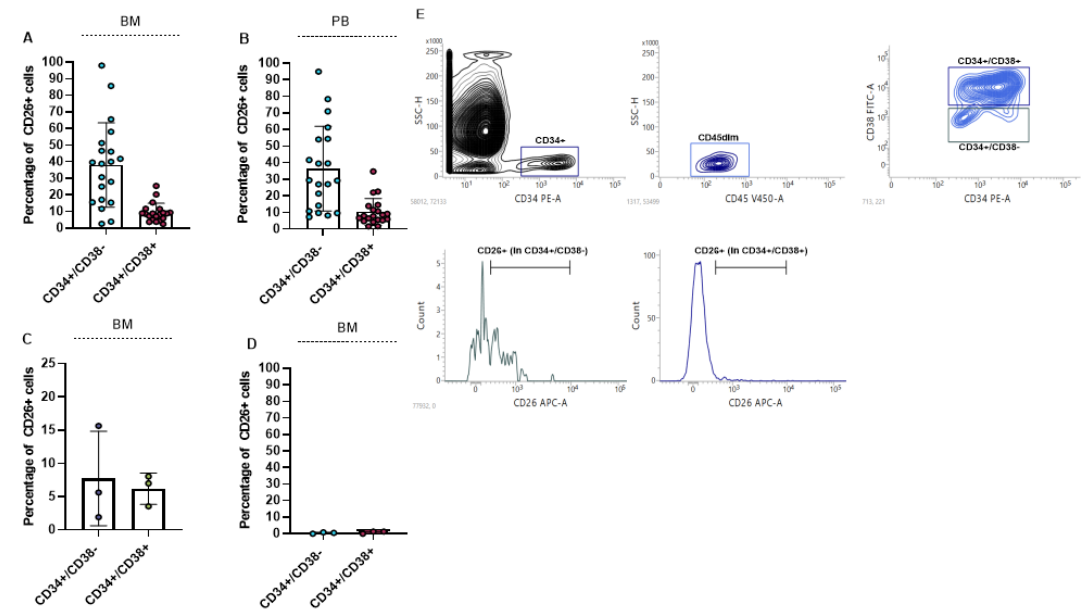
Figure 1. Percentage of CD26+ cells in newly diagnosed and resistant CML patients. ( A , B ) show percentage of CD26+ cells in CD45dim/CD34+/CD38 − (stem cells) and CD45dim/CD34+/CD38+ (progenitor cells) in BM and PB of newly diagnosed CML patients, respectively. CD26+ cells are also detectable in CML patients to resistant TKIs in both stem cells and progenitor cells compartment ( C ). CD26 was not detectable in stem/progenitor cells compartment of healthy donors ( D ). Flow cytometry graph and gating strategy of one newly diagnosed patient is depicted in ( E ).